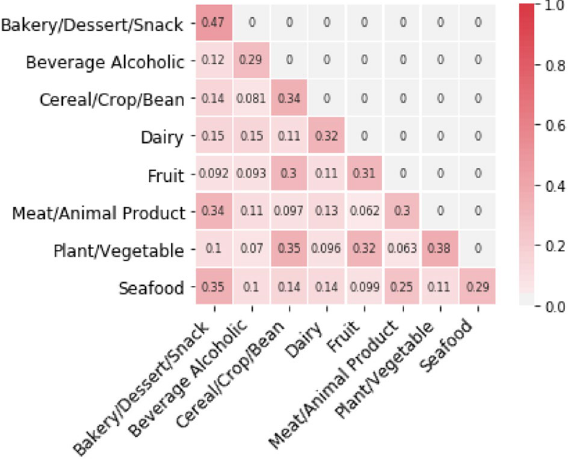
Figure 2. Chemical structure similarity between two categories. The scores in each box refer to the mean of all the Jaccard similarity scores of two ingredient chemical vectors within their categories. The ingredient chemical vectors are in one-hot vector fashion, which represents the presence of chemical compound in each ingredient.